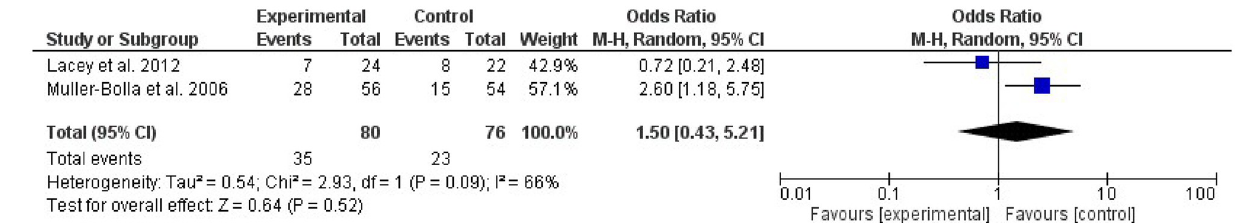
Fig 3. Meta-analysis of safety: Forest-plot of the differences in adverse events occurrence in the selected studies.